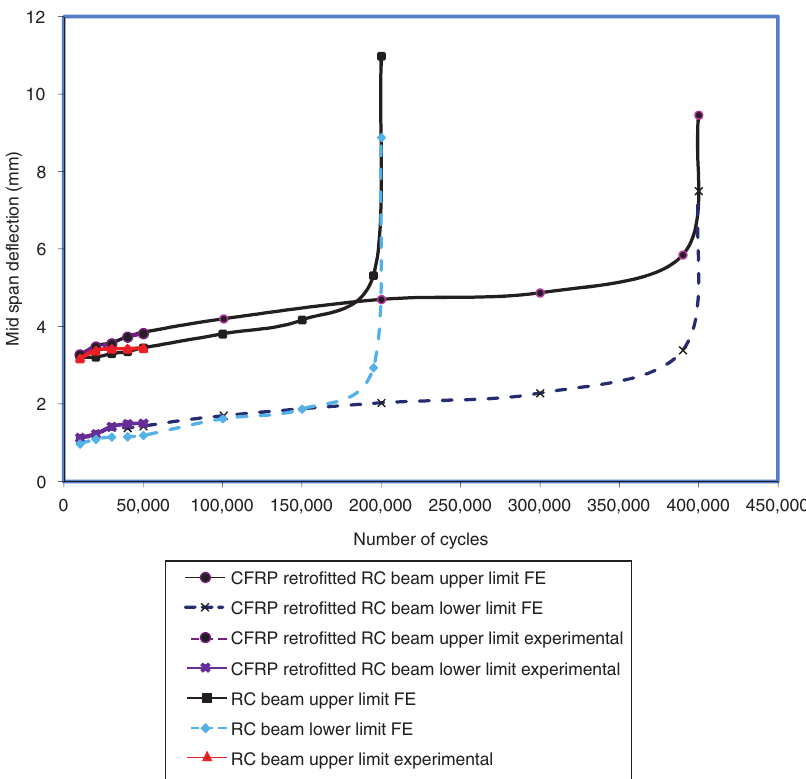
Figure 19: Mid-span deflection versus number of cycles for all the specimens used in the experimental and FE